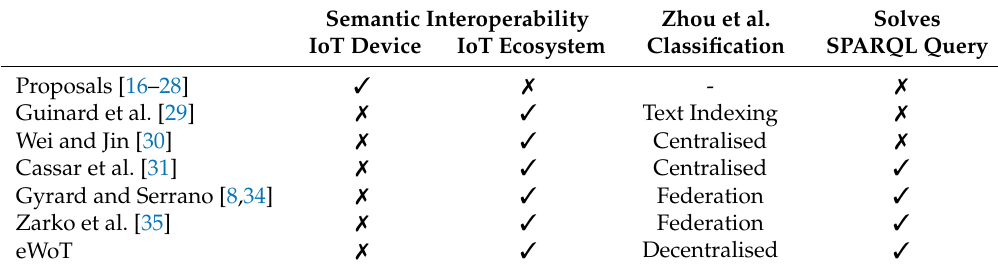
Table 1. Literature